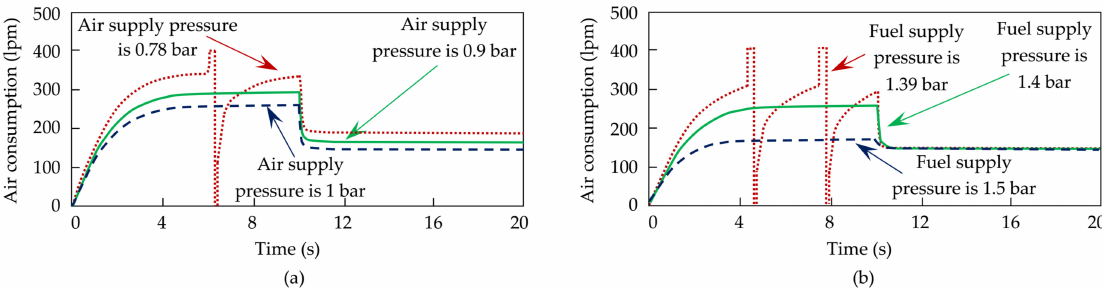
Figure 12. Air consumption for di ff erent: ( a ) air pressures; and ( b ) fuel pressures.